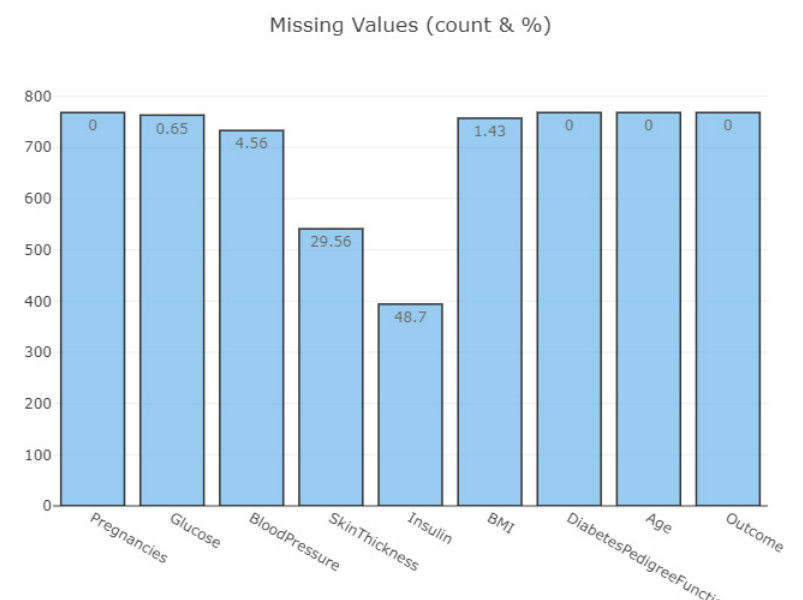
Figure 2. Features of a dataset with frequency distributions.